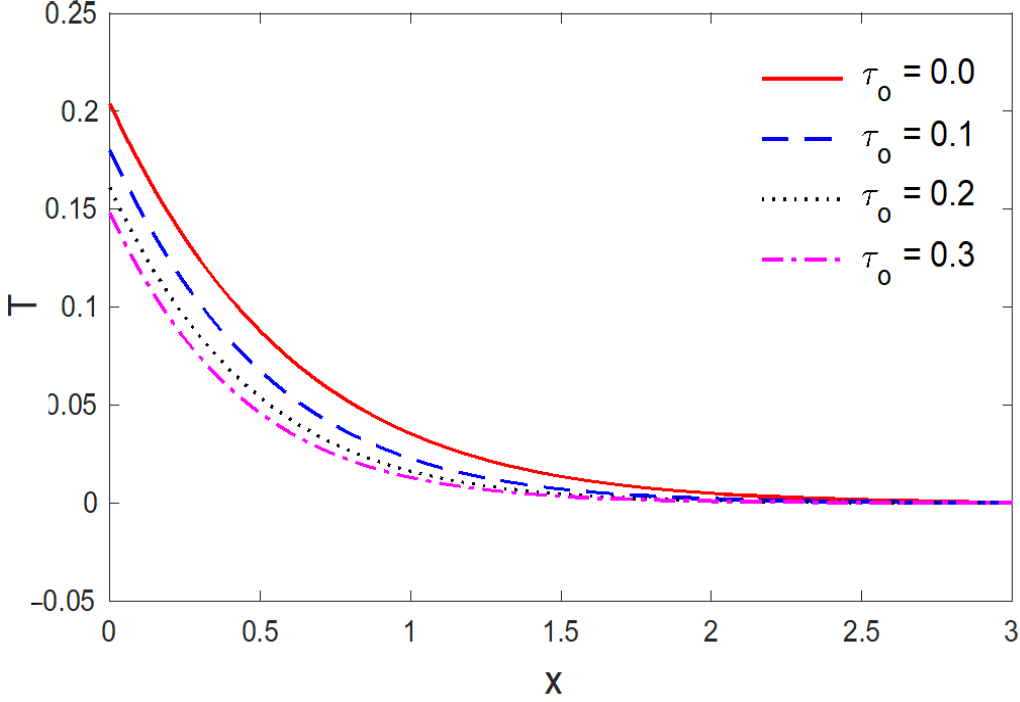
Figure 4. The variations of temperature via the distance for different values of τ o under (NLTEM).